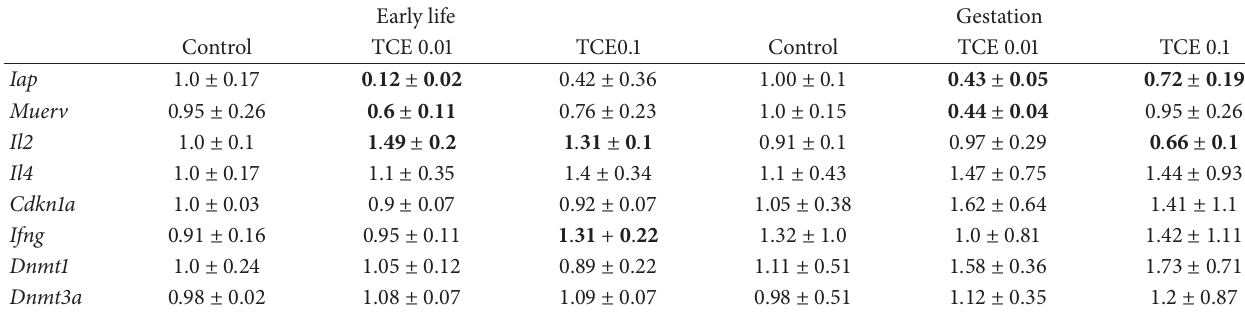
Table 2: Gene expression in CD4 + T cells from mice exposed to TCE during gestation or early life.